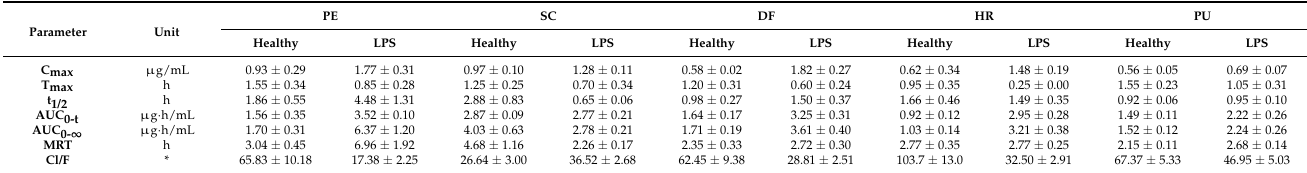
Table 4. Pharmacokinetic parameters of coumarins estimated by non-compartmental analysis in plasma after oral administration of hexanic extract of Tagetes lucida in healthy and LPS-damaged ICR